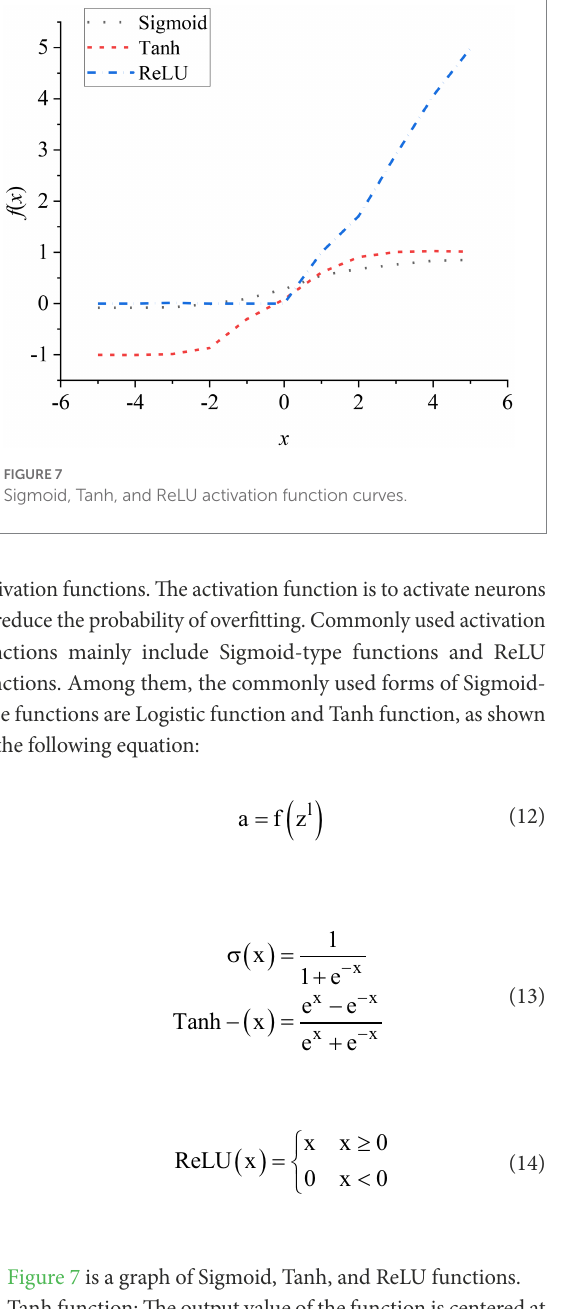
Figure 7 is a graph of Sigmoid, Tanh, and ReLU functions. Tanh function: The output value of the function is centered at 0. Although it has a faster convergence speed, there is a gradient dispersion. ReLU function is currently a commonly used activation function, which solves the gradient dispersion. And it has a fast convergence speed and it can reduce the possibility of overfitting. The LeakyReLU activation function is an improved version of the ReLU function. The calculation equation is